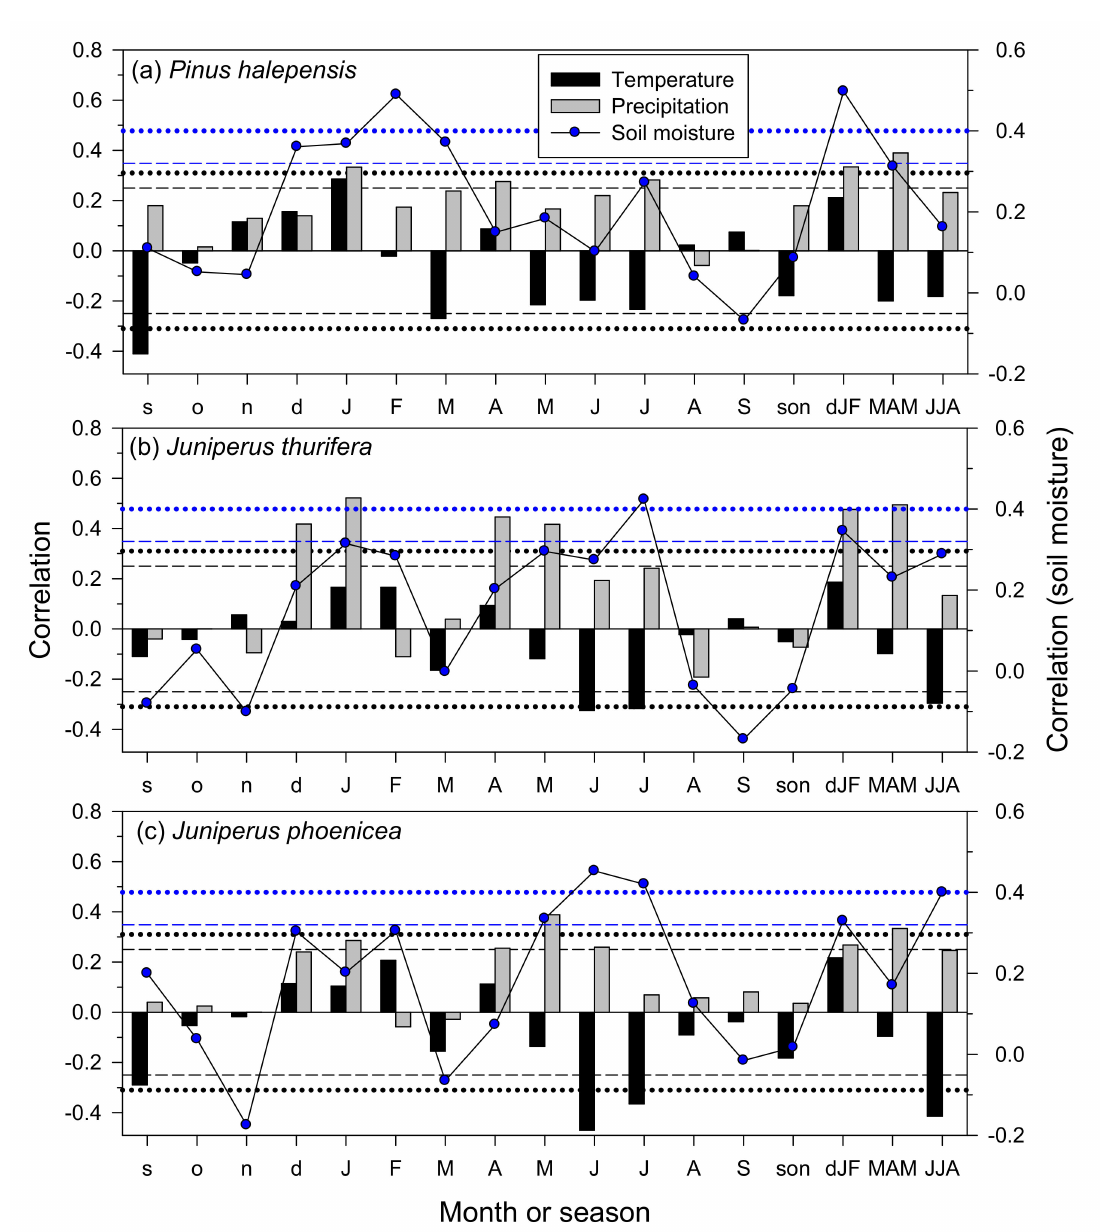
Figure 5. Monthly and seasonal climate–growth relationships of three species studied in the dry site. Horizontal dashed and dotted lines indicate the 0.05 and 0.01 significance levels, respectively. Note the different scales for the soil moisture (blue symbols with lines, right y -axes) and their significance levels (blue dashed and dotted lines). Months of the prior and current years are abbreviated using lowercase and uppercase letters,